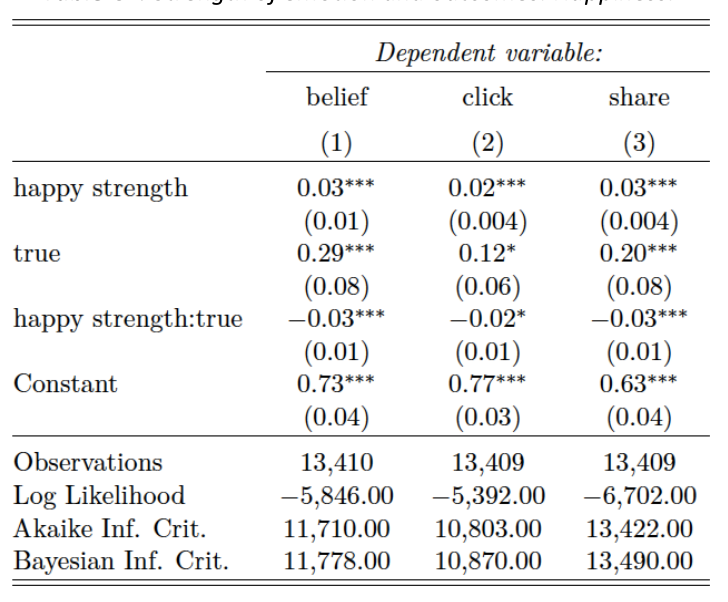
Table C1. Strength of emotion and outcomes: